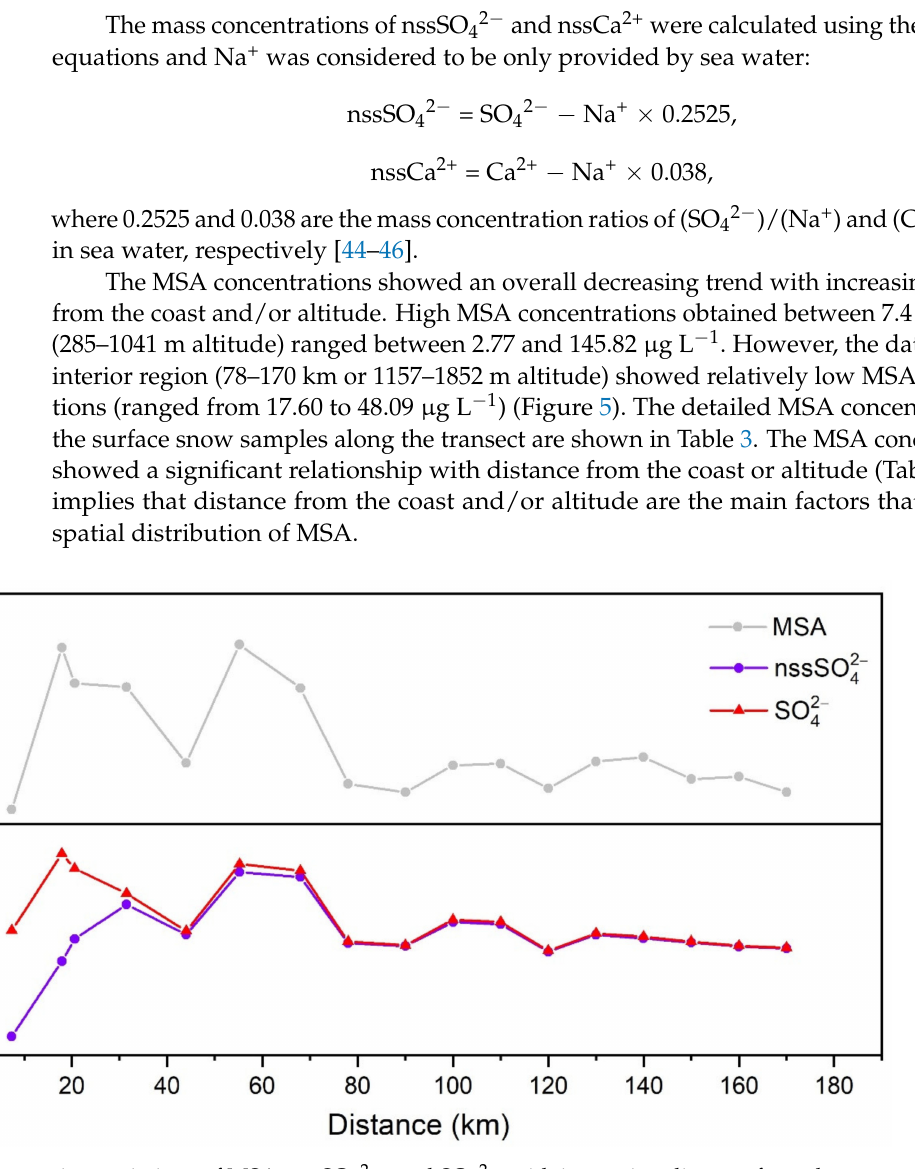
Figure 5. Concentration variations of MSA, nssSO 42 − , and SO 42 − with increasing distance from the